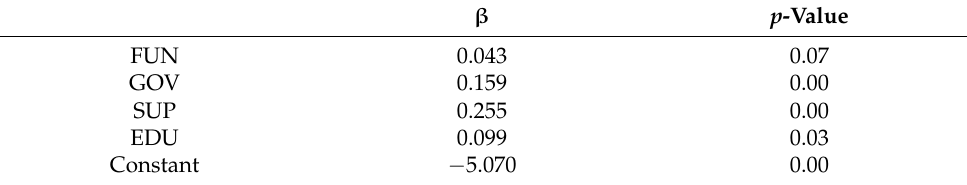
Table 12. Logistic regression results for COM4 (business coaching and mentoring) independent variable. β